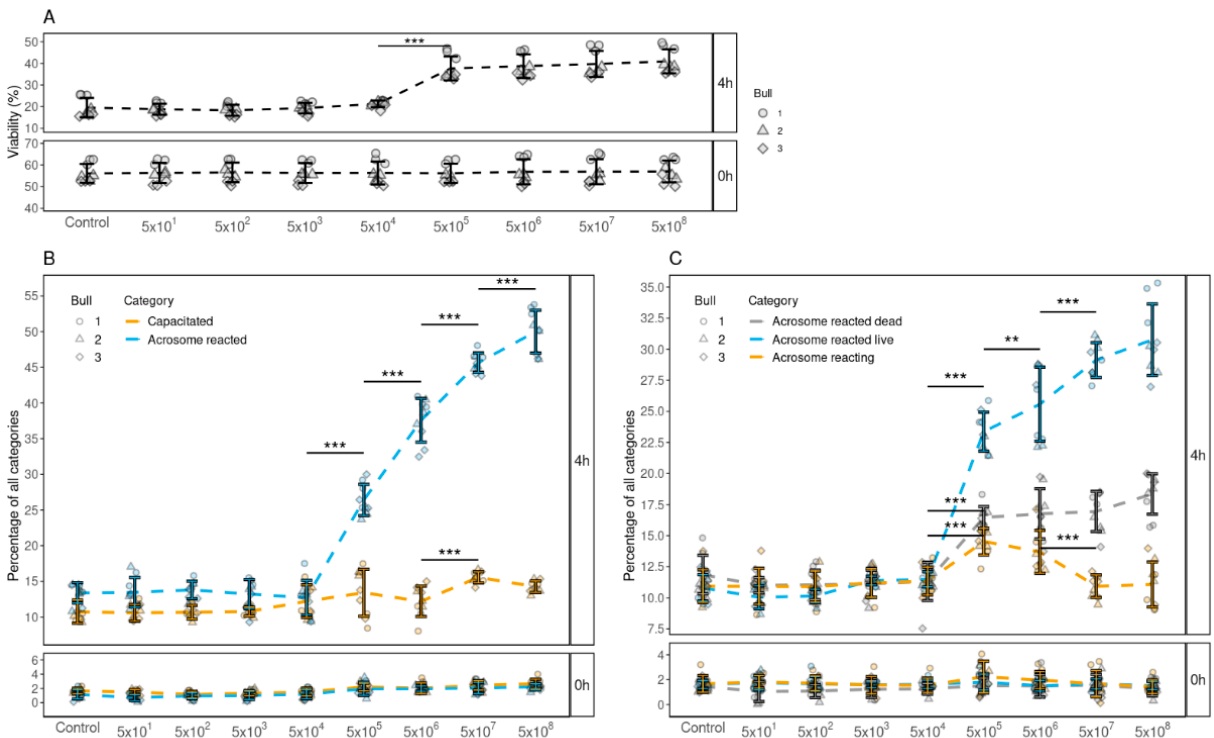
Figure 3. The effects of supplementing different concentrations of FF EVs (per 500 µ L) on the viability, capacitation and acrosome reaction of spermatozoa. ( A ) The percentage of live spermatozoa supplemented with different EV concentrations at 0 and 4 h. ( B ) The percentages of spermatozoa at different stages of capacitation reaction 0 and 4 h after supplementation with different EV concentrations. ( C ) The percentages of spermatozoa in different stages of acrosomal reaction 0 and 4 h after supplementation. Error bars display the mean ± standard deviation (SD). In the background, different symbols represent measurements of samples from different bulls. Asterisks mark statistically significant differences between different concentrations and relate to p-values as follows: * p ≤ 0.05; ** p ≤ 0.01; *** p ≤ 0.001. Whereas all pairwise comparisons were conducted, statistically significant differences are marked only for adjacent concentrations.